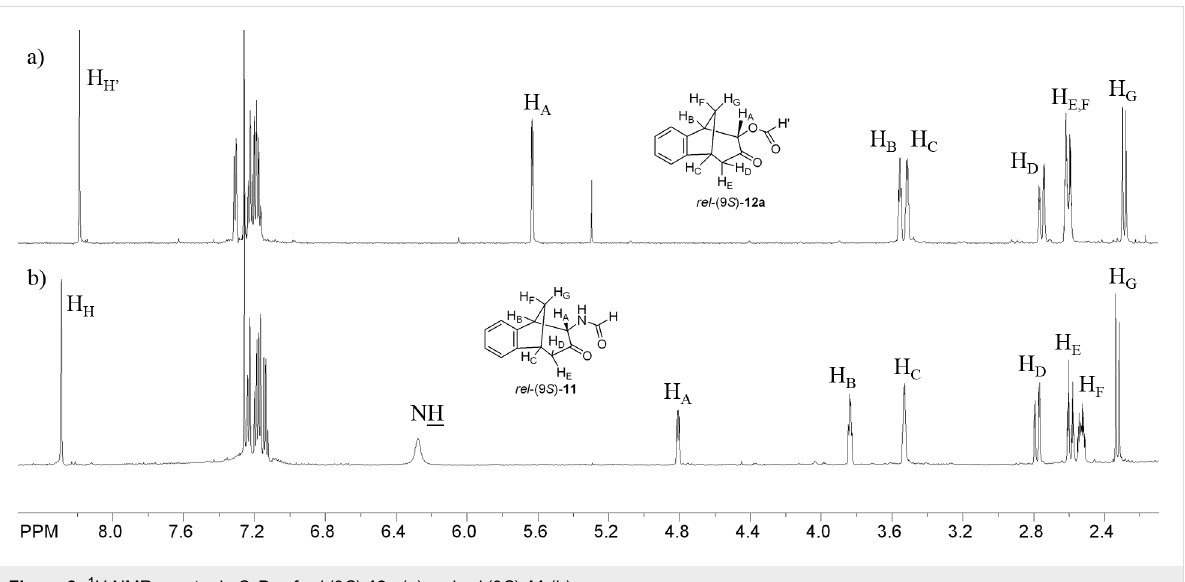
Figure 2: 1 H NMR spectra in C 6 D 6 of rel -(9 S )- 12a (a) and rel -(9 S )- 11